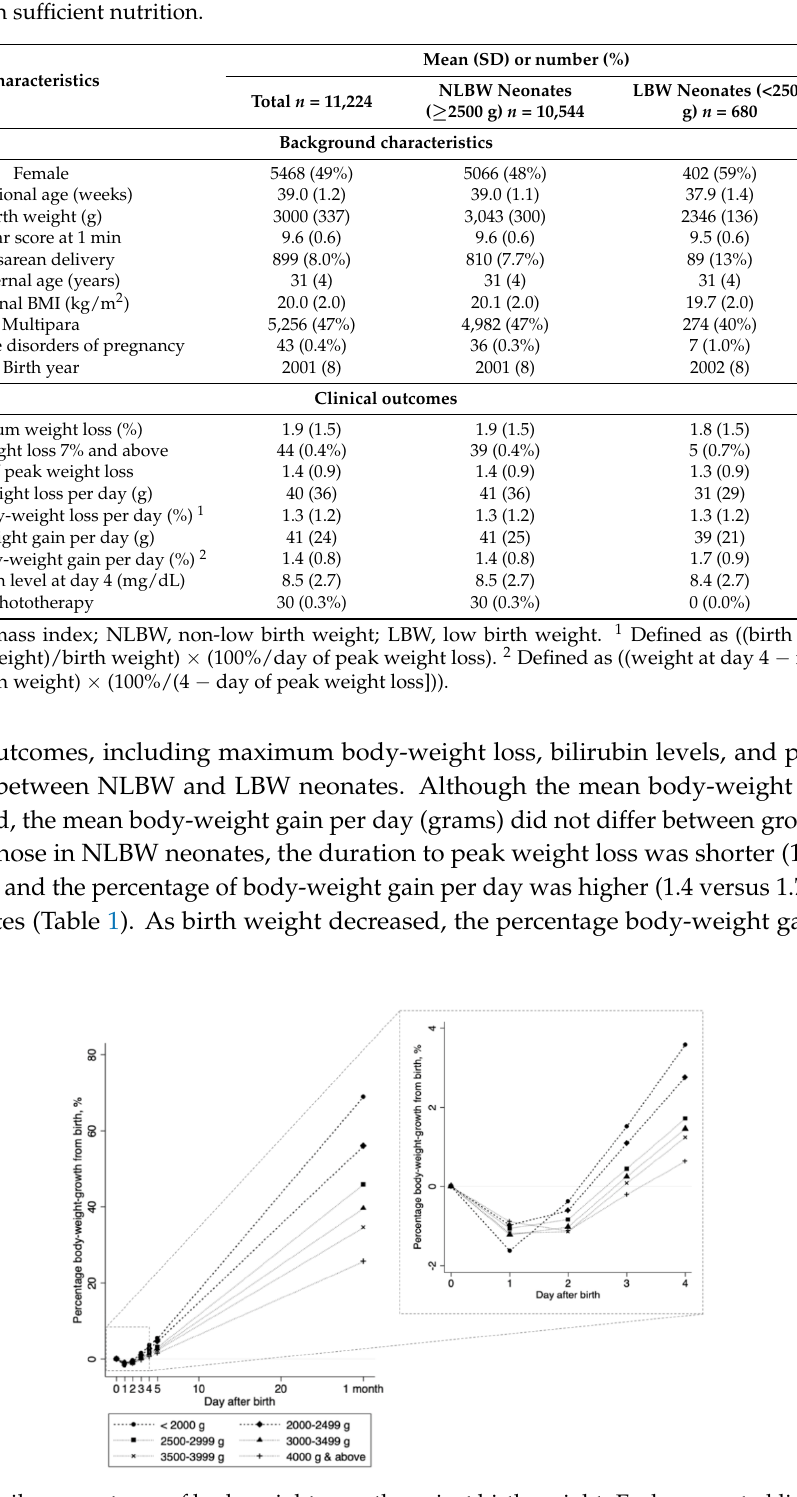
Figure 3. Daily percentages of bodyweight growth against birth weight. Each connected line shows the change in the percentage bodyweight growth from birth weight (([weight at every day − birth weight]/birth weight) × 100%), stratified by birth weight categories. Values from day 0 through day 4 were estimated in 11,224 neonates; values at day 5 and 1 month (approximately 30 days of birth) were estimated in 10,336 neonates and 8071 neonates, respectively.